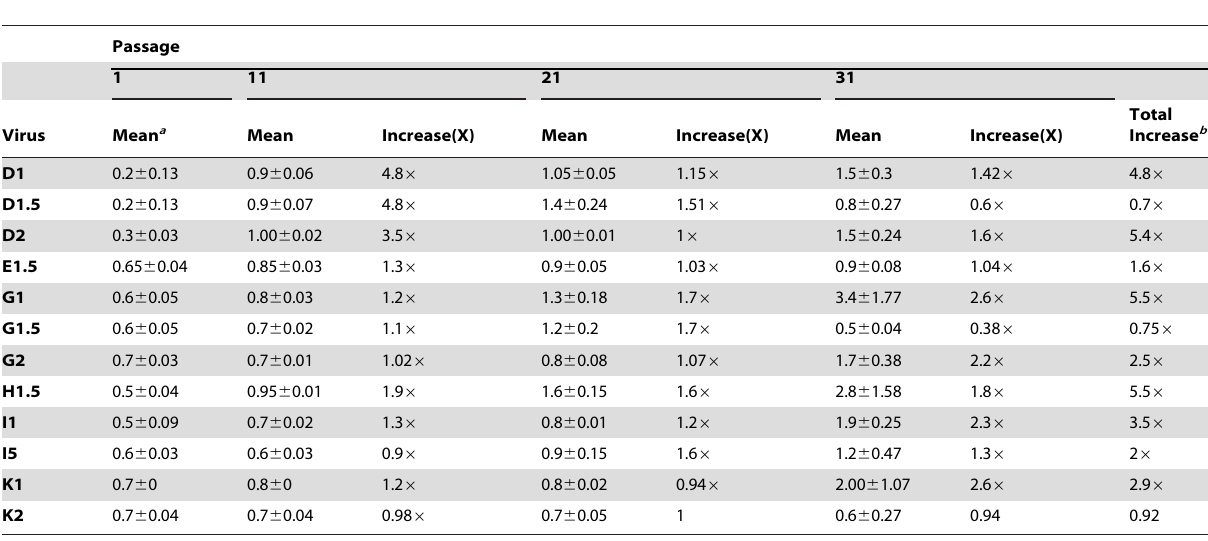
Table 2. Fitness values of the viruses and their increases during the recovery passages.